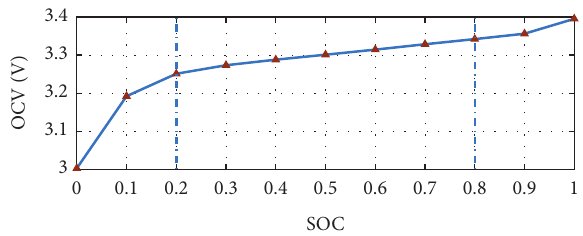
Figure 7: OCV versus SOC characteristic of the experimental LIB